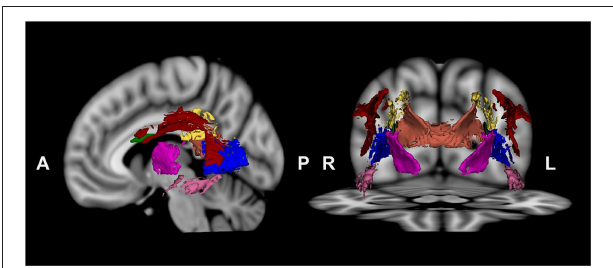
FIGURE 1 | Visuospatial function network regions, including the superior longitudinal fasciculus (red), posterior thalamic radiation (blue), posterior corona radiata (yellow), splenium of the corpus callosum (orange), posterior limb of the internal capsule (dark pink), sagittal stratum (pink), and superior fronto-occipital fasciculus (green), were